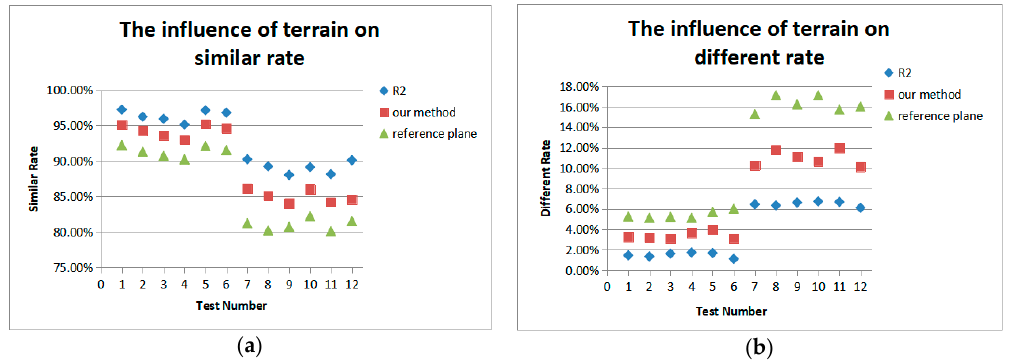
Figure 22. The influence of terrain on the algorithms: ( a ) influence of terrain on the Similar Rate of each algorithm; and ( b ) influence of terrain on the Different Rate of each algorithm. For Figure 22, the first six terrain points were on the plain, and the latter six terrain points were on